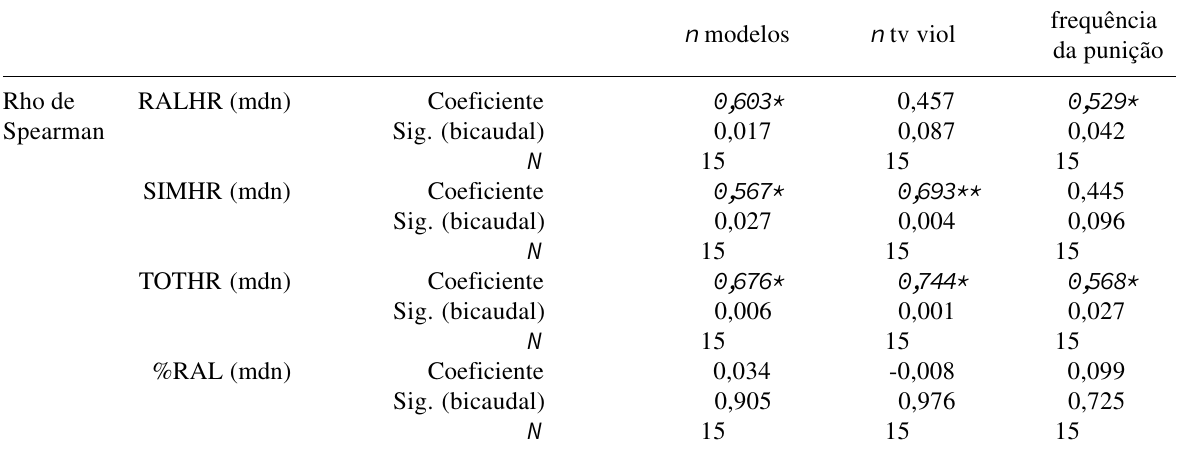
Correlações Não-Paramétricas Entre os Fatores Medidos de Forma Discreta e as Medidas de